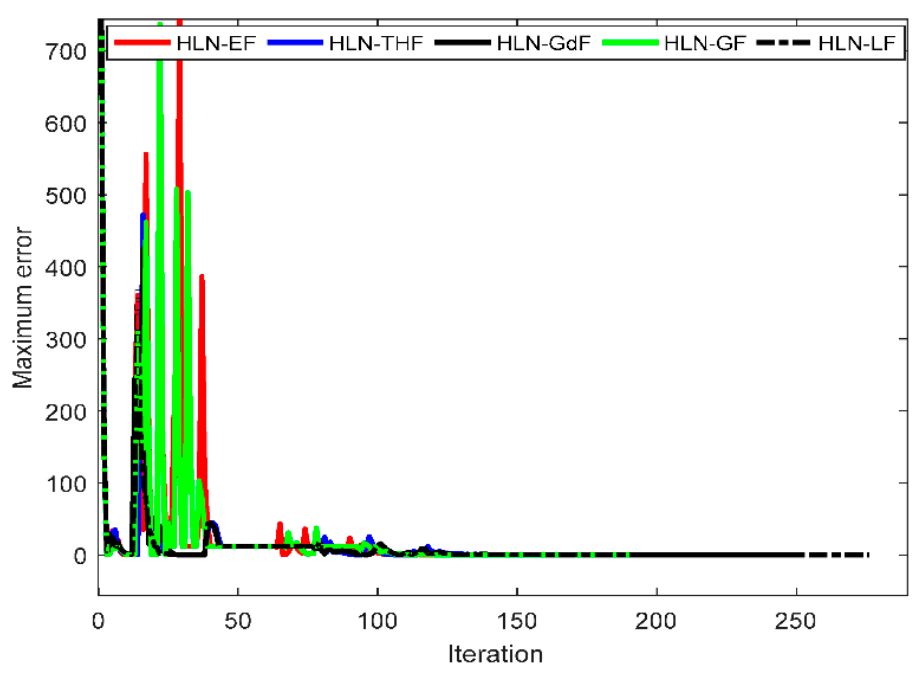
Figure 8. Maximum error vs. iteration for the second system with the first model of payment.